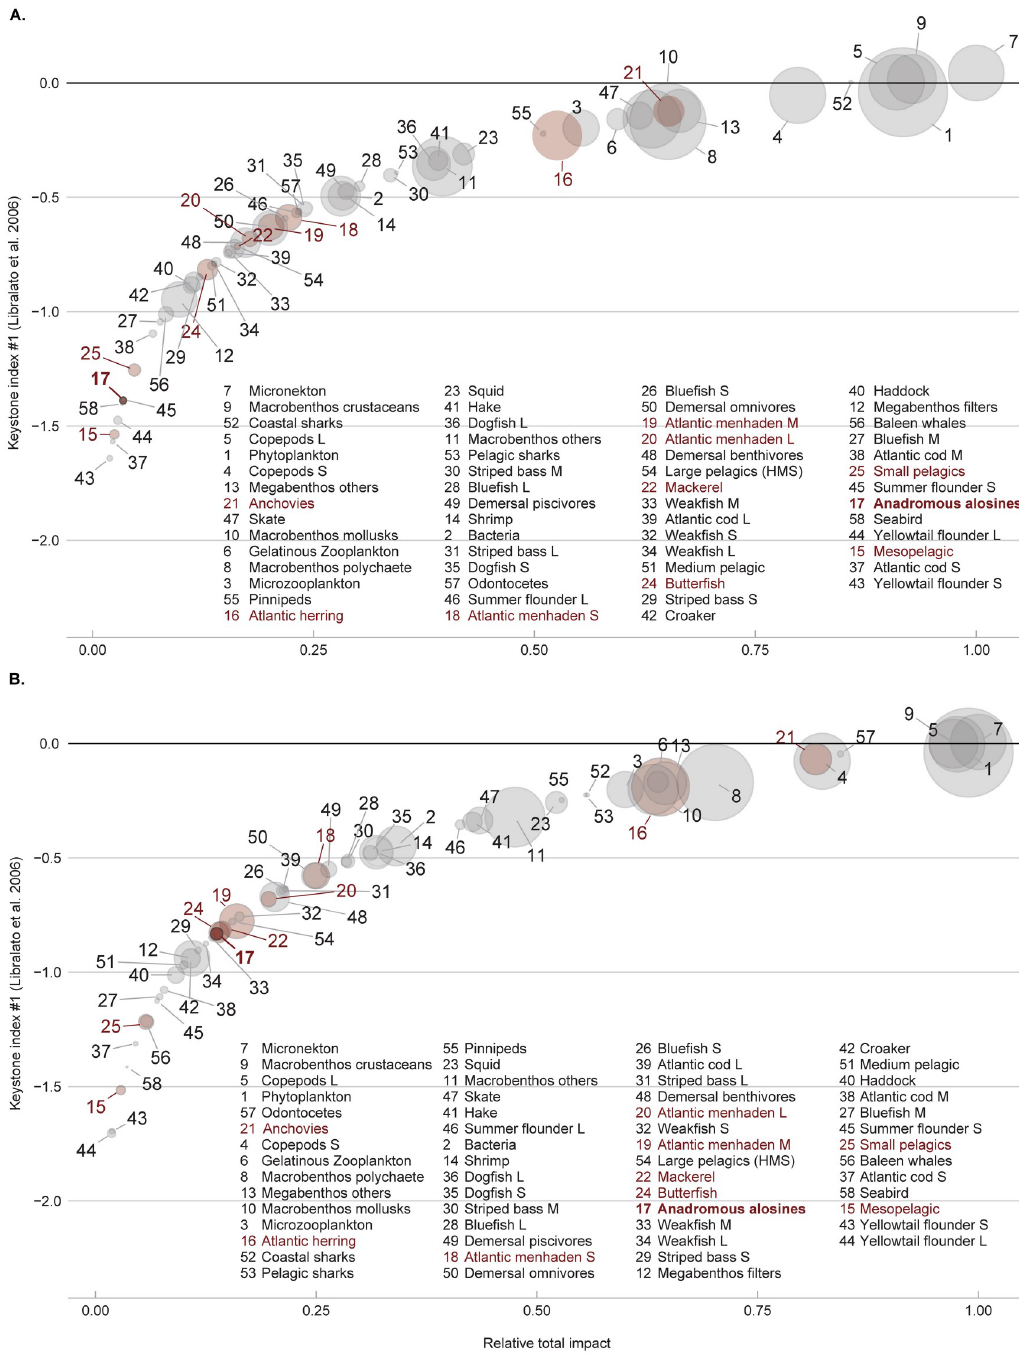
Fig 6. Keystoneness analysis for both models using KS 1 index. The functional group lists are ranked and ordered in terms of keystoneness, and circle size reflects biomass. (A) Keystoneness and biomass for the CAB, (B) keystoneness and biomass for the RAB model. Forage fish species are highlighted in red, and anadromous alosine group is in bold.